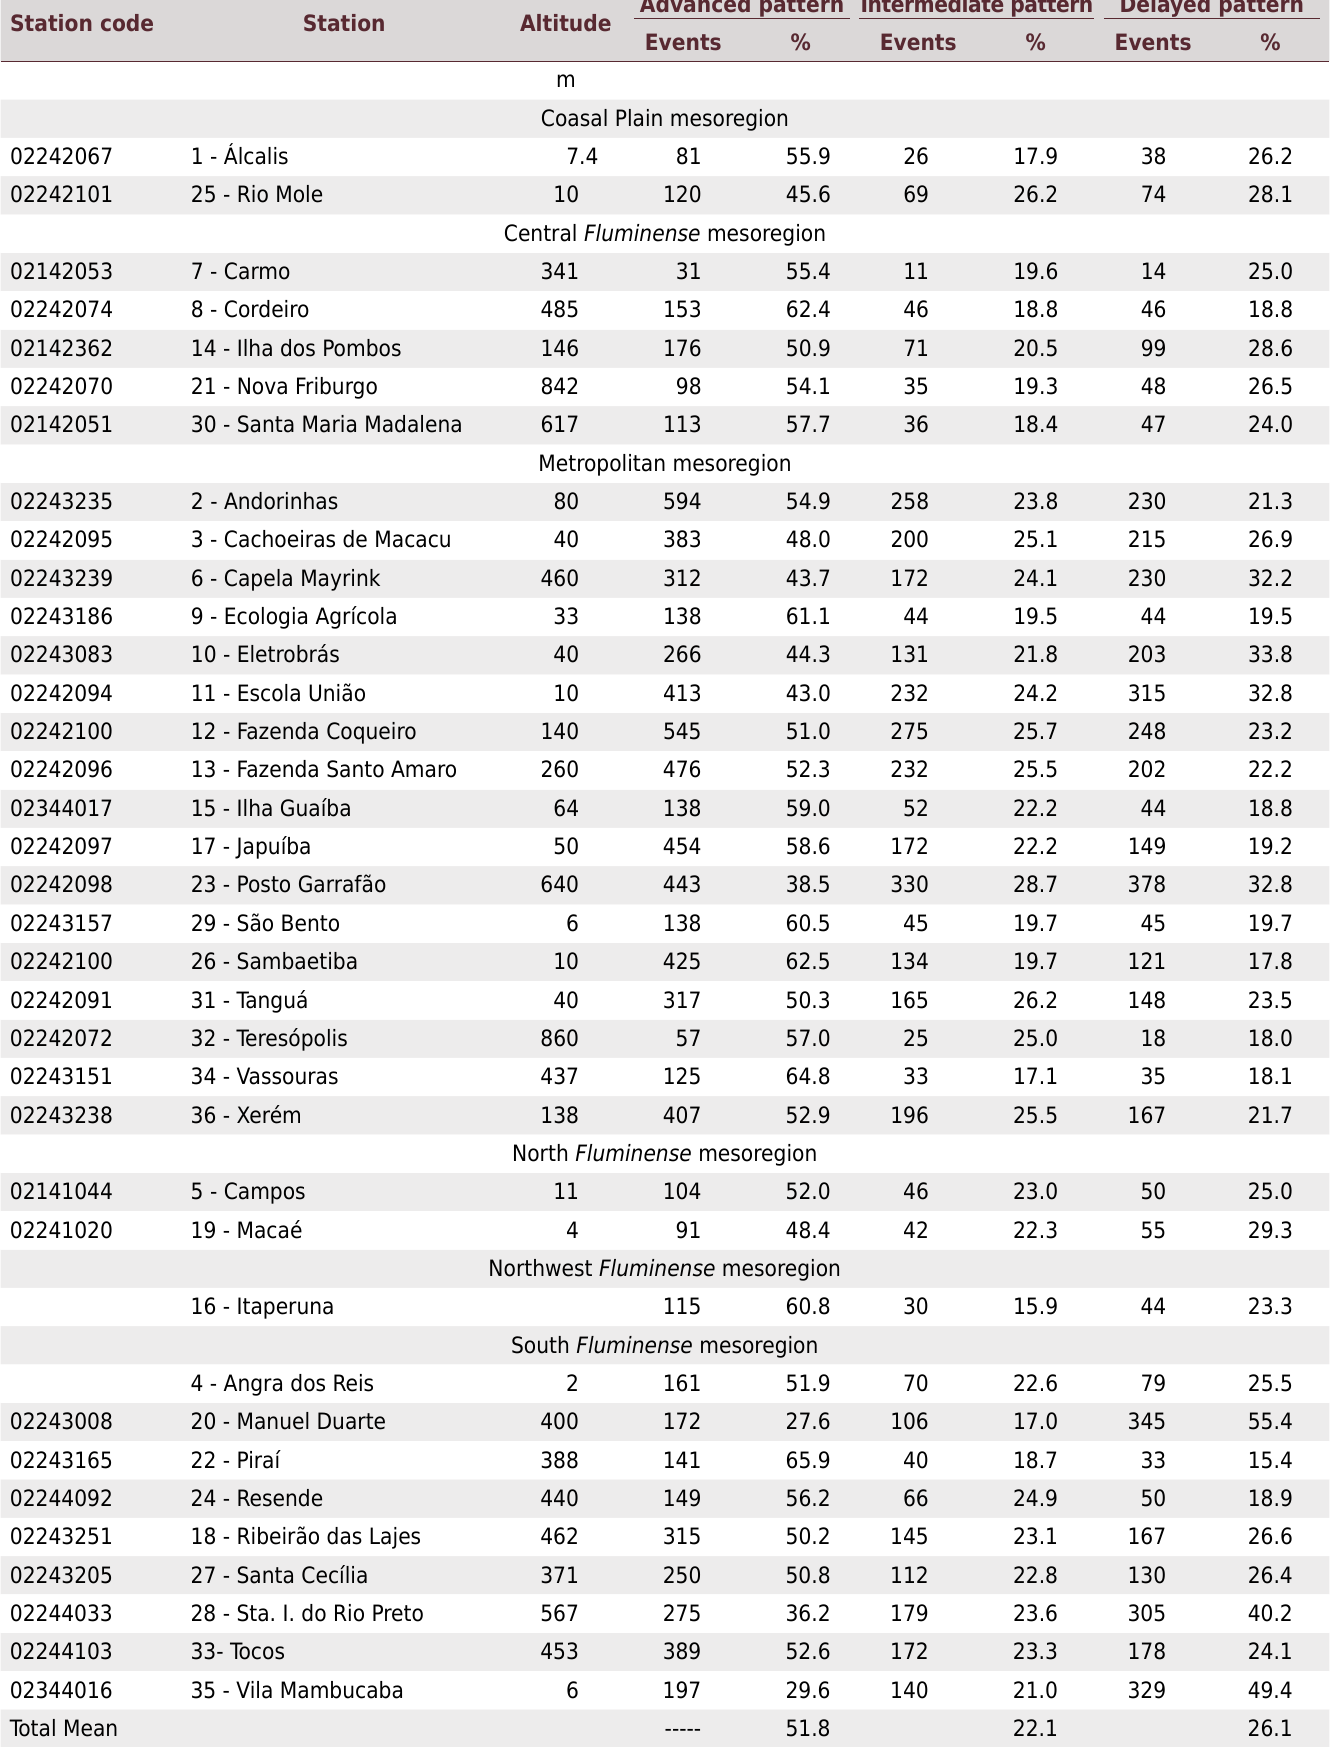
Table 1. Rainfall patterns for different stations in the state of Rio de Janeiro, Brazil Station